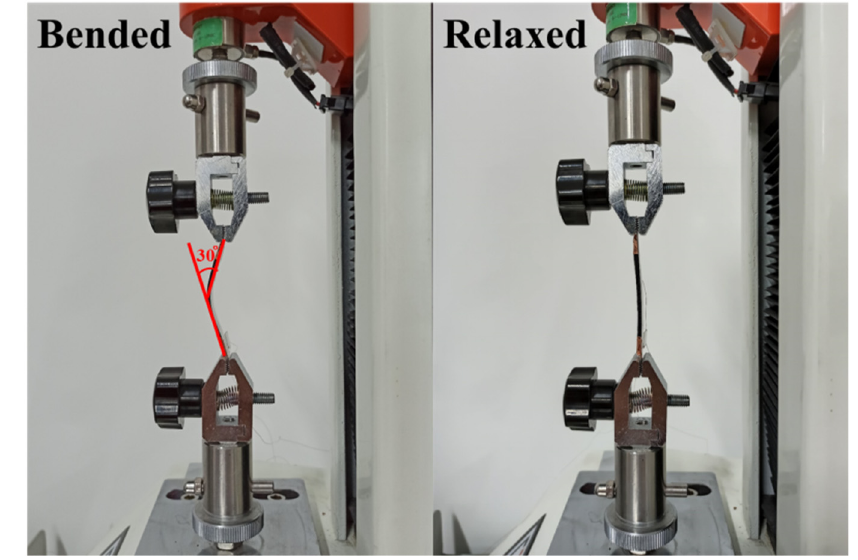
Figure 7. Bending test diagram of the flexible strain sensor on a PET substrate.